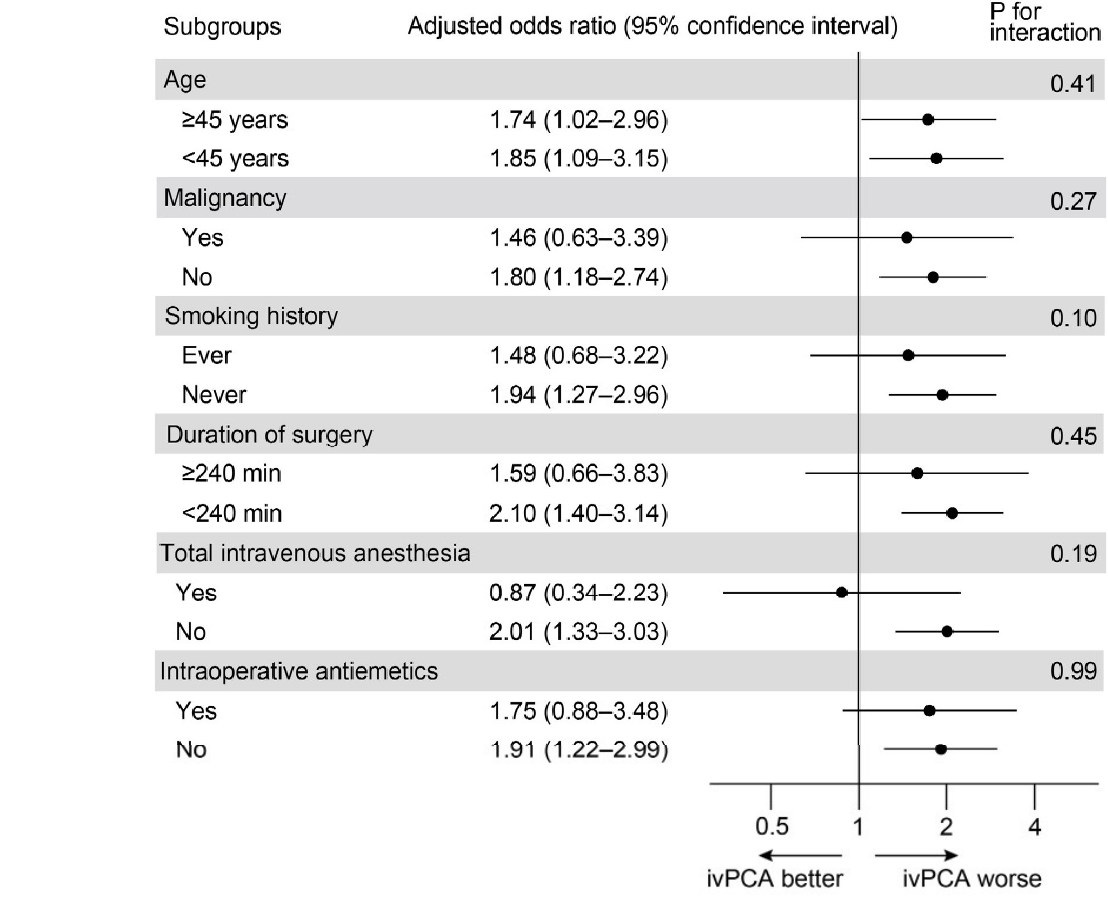
Figure 2. Subgroup analyses stratified by patient and operative